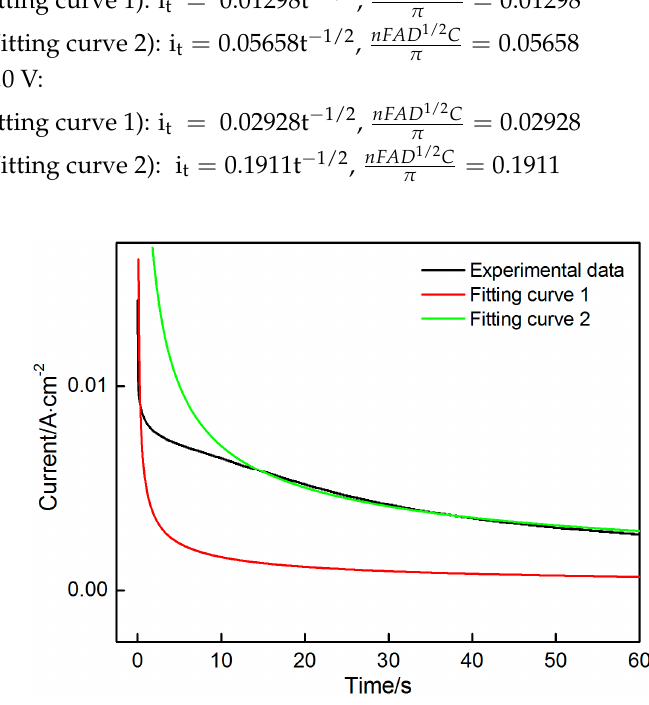
Figure 4. Fitting results in the first and third stages at the potential of 1.3 V.